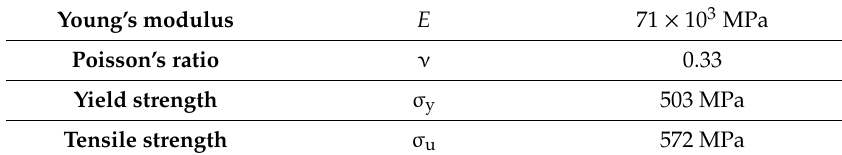
Table 2. Mechanical properties for the Al 7075-T651 alloy, data from [32].